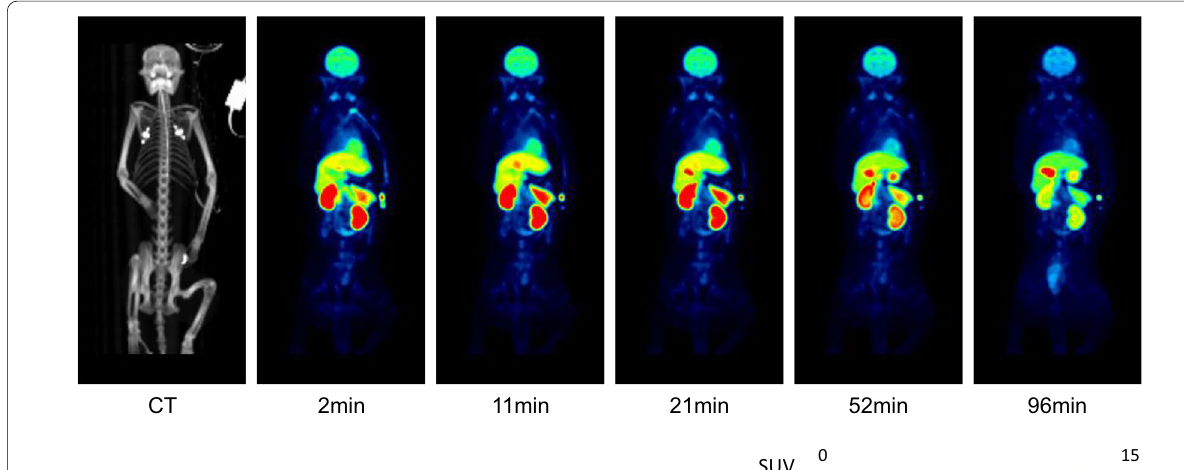
Fig. 6 Representative whole-body PET images of [ 11 C]PF-06809247